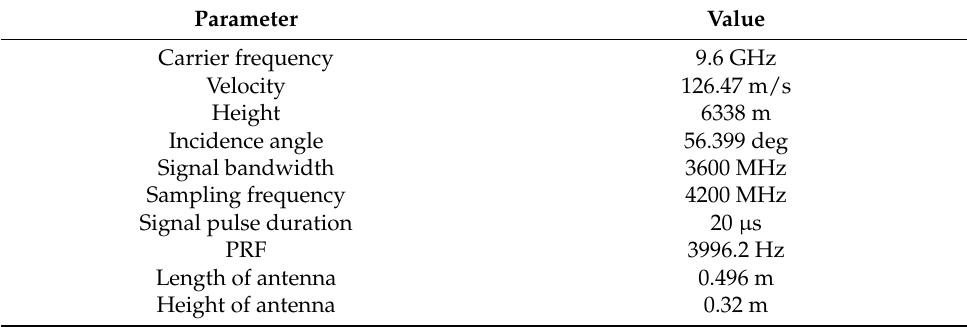
Figure 18. ( a ) Area A imaged with TSM MoCo scheme. ( b ) Area B with TSM MoCo scheme. ( c ) Area C imaged with TSM MoCo scheme. ( d ) Area A imaged with traditional OSM MoCo scheme. ( e ) Area B with traditional OSM MoCo scheme. ( f ) Area C imaged with traditional OSM MoCo scheme. ( g ) Area A with the proposed MoCo scheme. ( h ) Area B imaged with the proposed MoCo scheme. ( i ) Area C with the proposed MoCo scheme. Table 8. Parameters of the